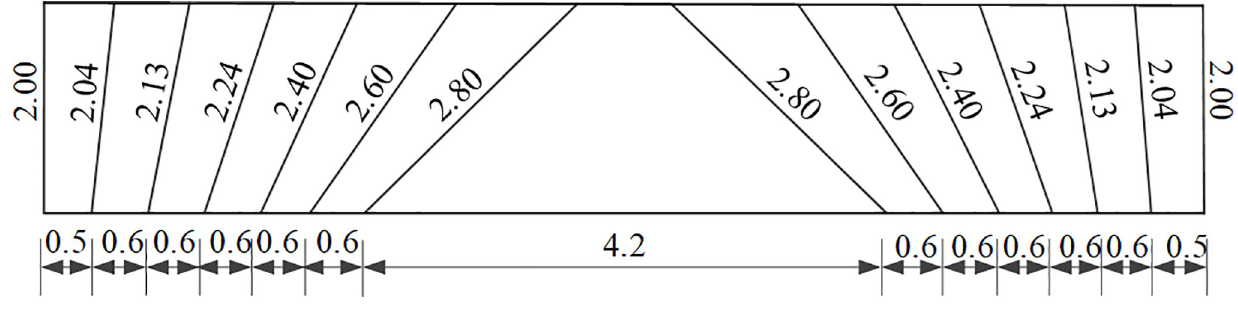
Fig 6. Spacing in drilling and lengths of the holes.